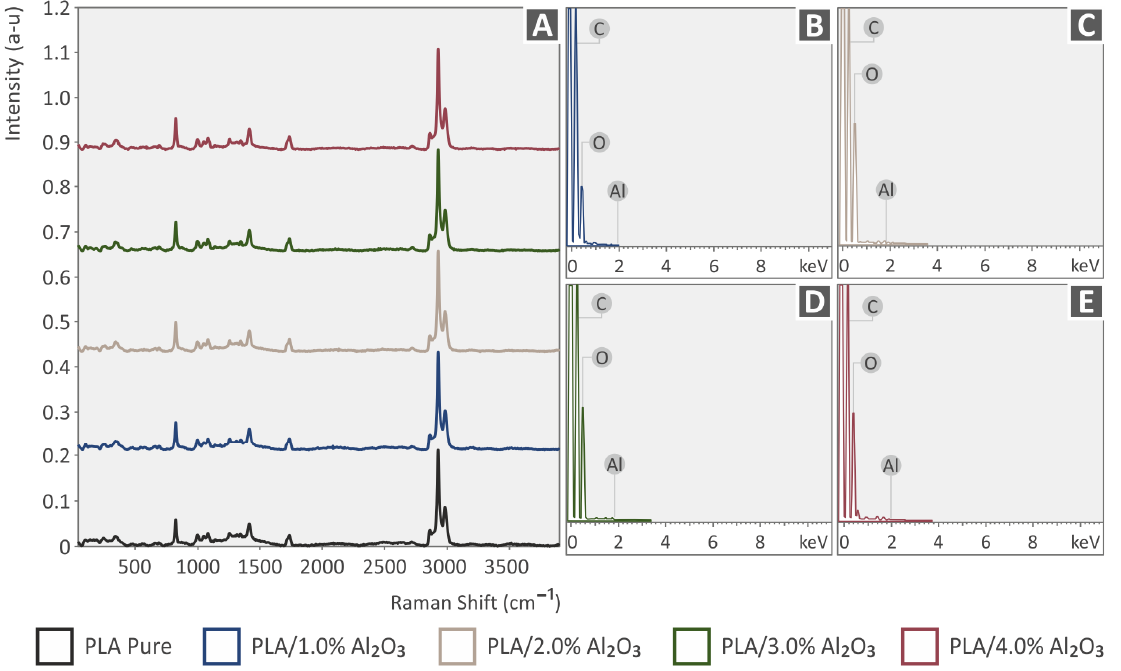
Figure 4. (A) Raman spectra for neat PLA, PLA with 1.0 wt.% Al 2 O 3 , PLA with 2.0 wt.% Al 2 O 3 , PLA with 3.0 wt.% Al 2 O 3 , and ( B – E ) EDS spectra for all 3DP PLA/Al 2 O 3 nanocomposites showing the existence of atomic Al arising from the Al 2 O 3 incorporated nanoparticles in the PLA polymer matrix. Table 2. Major Raman peaks identified and their related assignments.